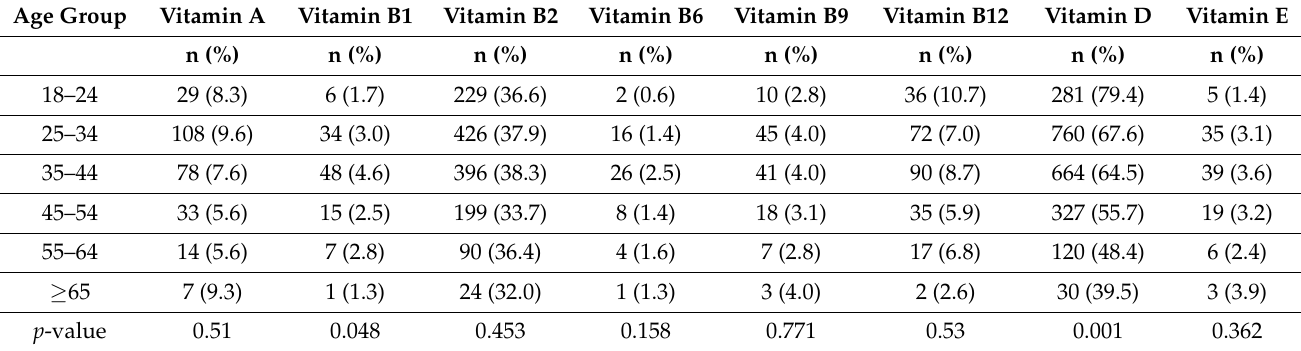
Table A2. Distribution of the Vitamin Deficiencies Categorized by Age Group, Saudi Arabia.